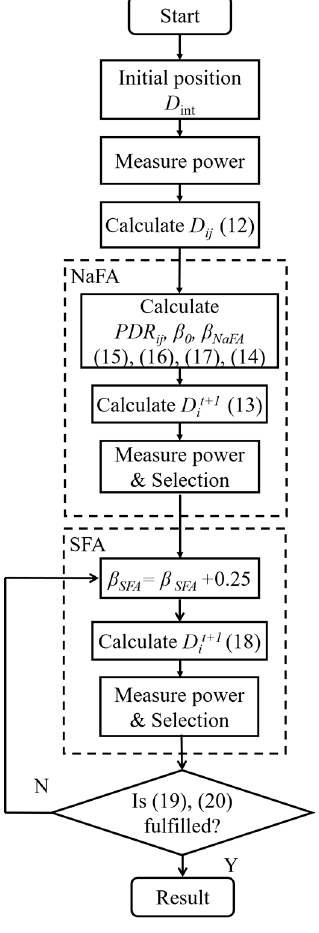
Figure 7. Processing flow of the modified firefly algorithm (MFA).